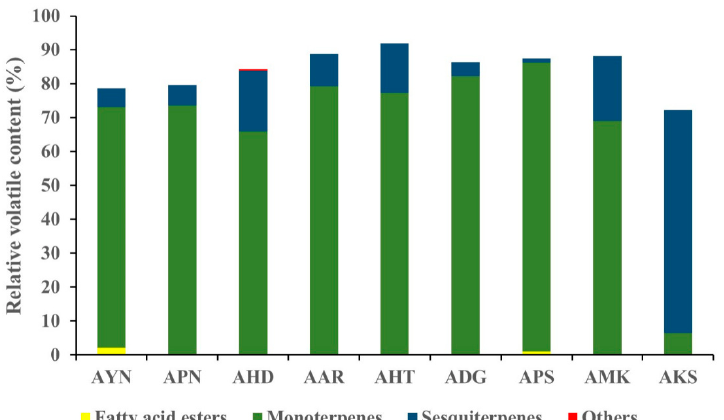
Figure 4. Graph representing the relative content of identified compound classes in the floral volatiles of nine Aster species.